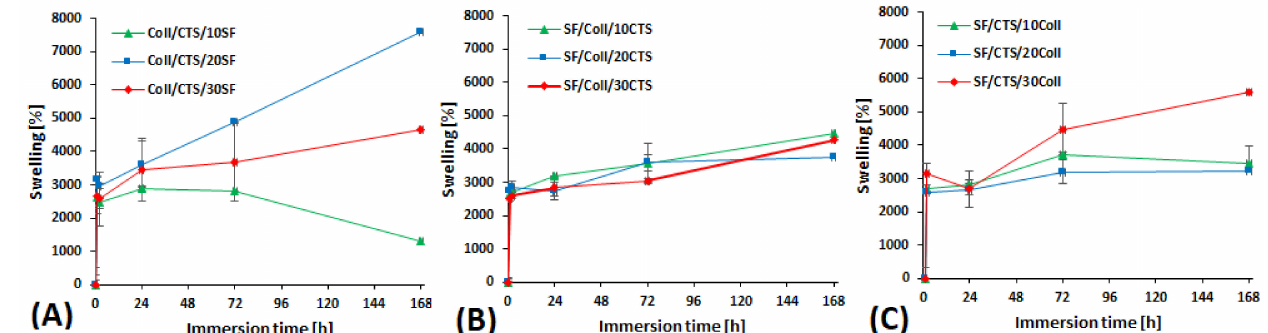
Figure 5. Swelling behavior of the studied scaffolds, cross-linked by EDC/NHS: ( A ) Coll/CTS mixture with 10, 20 and 30% of SF; ( B ) SF/Coll mixture with 10, 20 and 30% of CTS; ( C ) SF/CTS with 10, 20 and 30% of Coll.